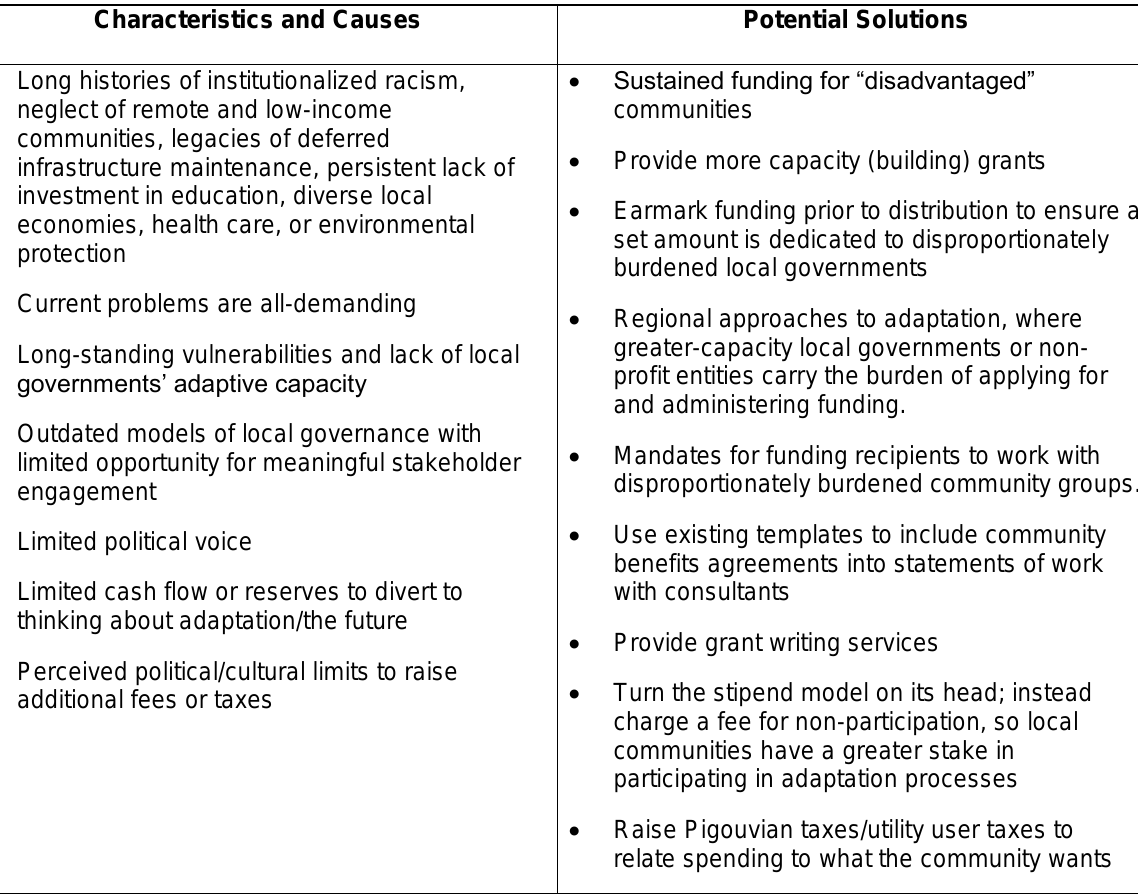
Table A2.4: Characteristics, Underlying Causes and Potential Solutions to Address the Disproportionate Burden Archetype Characteristics and Causes